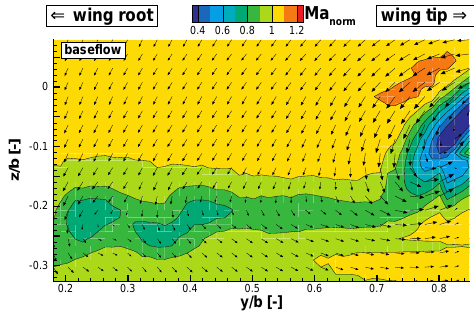
Figure 21. Wake flow at ( α max , base + 0.7 ◦ ) for the base flow.